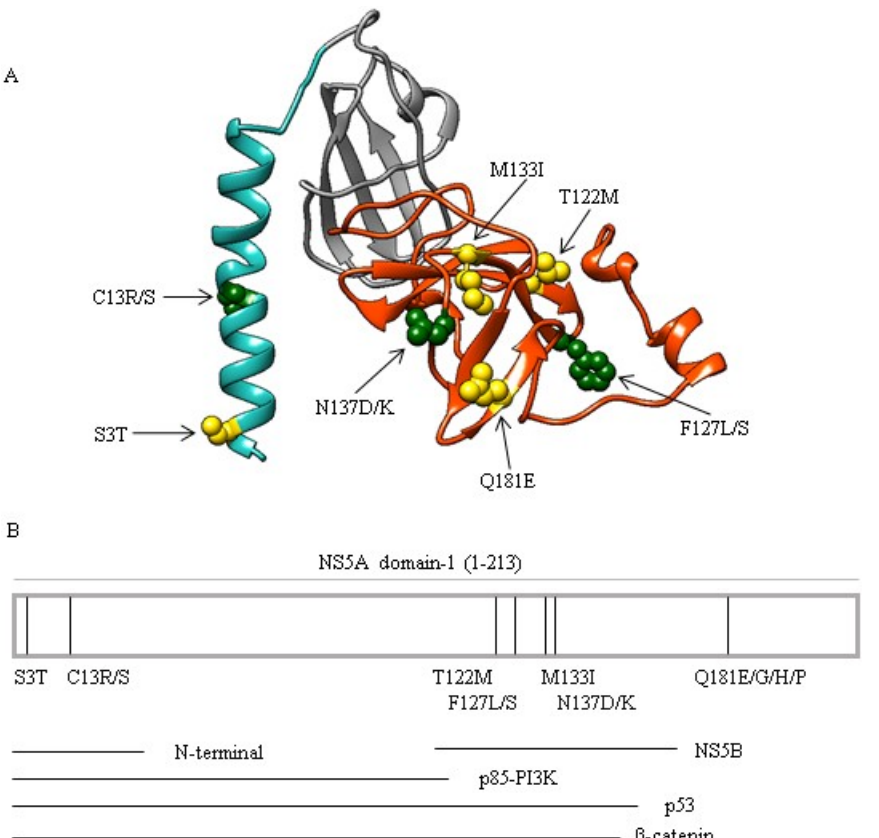
Figure 2. Localization of mutations in NS5A. ( A ) Three-dimensional structure of the NS5A domain-1 showing the localization of mutations associated with HCC. Cyan alpha helix refers to N-terminal NS5A, grey beta-sheets refer to zinc binding domain, while orange beta-sheets refer to NS5A domains involved in binding to NS5B and viral RNA genome. The four mutations associated with HCC are highlighted in yellow, while the three residues with significantly higher variability in the HCC group are highlighted in green. ( B ) Schematic representation of the NS5A domain-1 (213 amino acids) showing the localization of the mutations associated with HCC in NS5A domain-1 region involved in the interactions with the cellular proteins (p53, p85-PI3K, and β -catenin), and with the viral protein